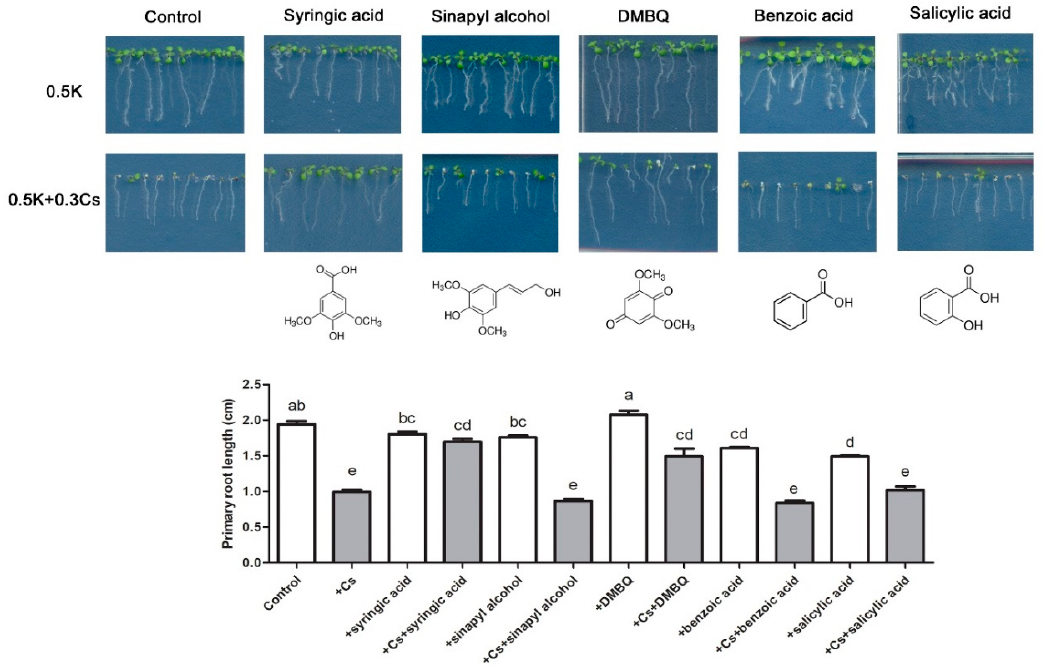
Figure 3. Phenotype analysis of cesium-induced growth inhibition in Arabidopsis seedlings treated with various phenolic compounds. Wild-type Arabidopsis Col-0 was grown for 8 days on media containing 0.5 mM potassium (K) and 0.3 mM cesium (Cs) supplemented with either 100 μ M syringic acid, 100 μ M sinapyl alcohol, 10 μ M 1,6-dimethoxybenzoquinone (DMBQ), 10 μ M benzoic acid, or 10 μ M salicylic acid. Statistically significant differences were determined by a one-way ANOVA with Bonferroni’s multiple comparison post-test and are indicated with different letters ( p < 0.05). Error bars represent the SE.